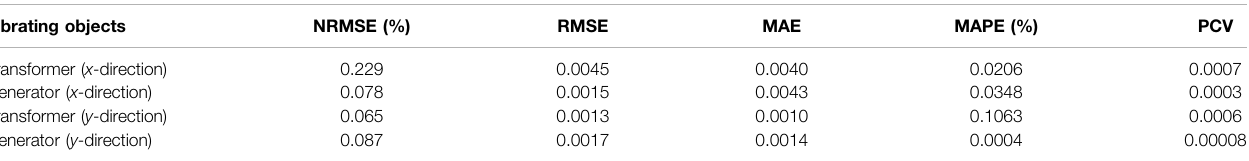
TABLE 3 | Calculation error of vibration vector under different videos. Vibrating objects Transformer ( x -direction)